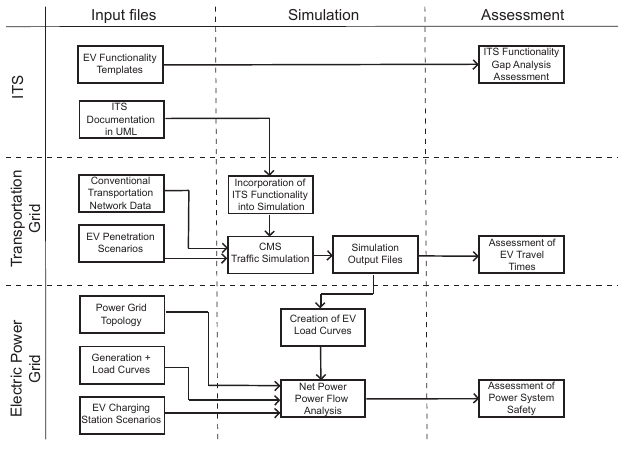
Figure 2. Methodology of assessment [1–3].